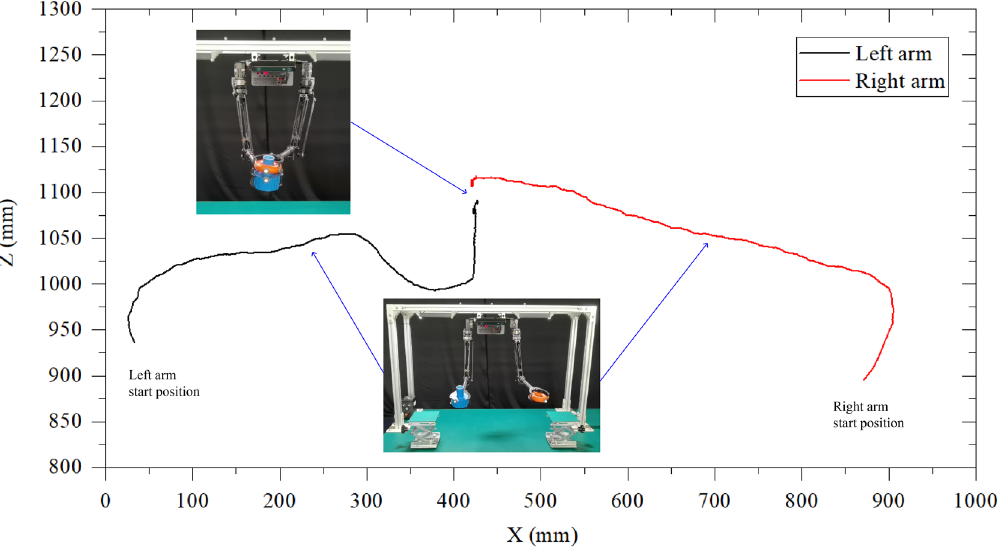
Figure 14. Analysis of position trajectory changes in cooperative dual-arm manipulation test.